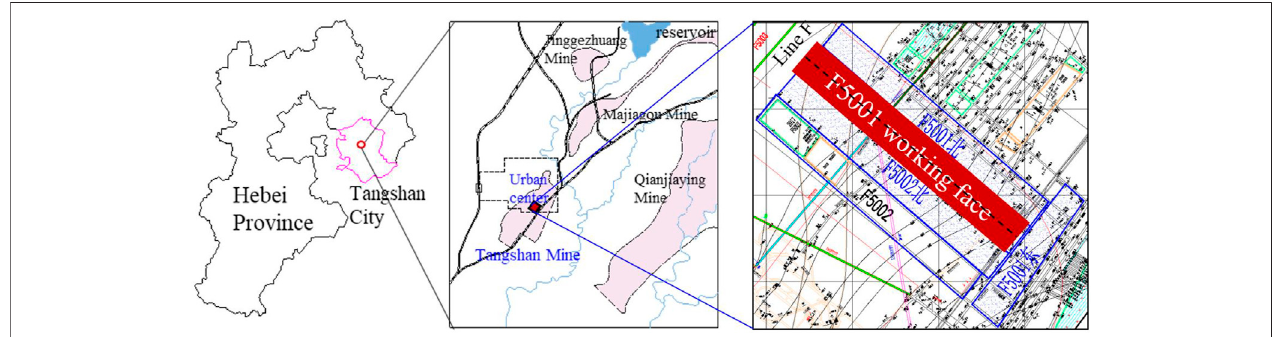
FIGURE 1 | Location of the Tangshan mine and the layout of working face F5001.